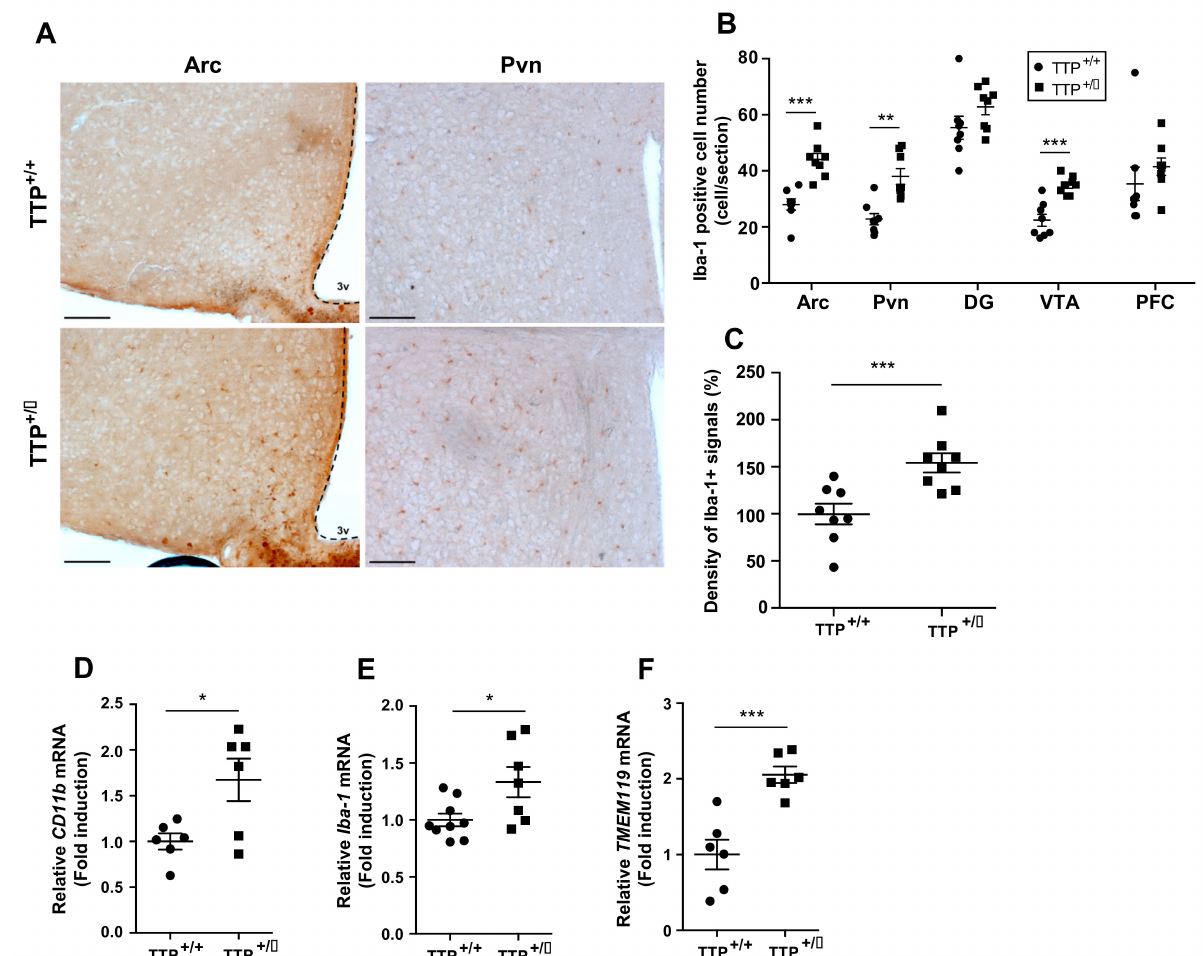
Figure 4. Deficiency of TTP leads to the activation of microglia in the hypothalamus. ( A ) Representative images show immunosignals of Iba-1 protein, a molecular marker for microglial cells, in the hypothalamus as determined by IHC. ( B ) Iba-1 positive cells were significantly elevated in hypothalamic arcuate nucleus (Arc), paraventricular nucleus (Pvn) and ventral tegmental area (VTA), but not significantly altered in the hippocampal dentate gyrus (DG) and prefrontal cortex (PFC) of the TTP-deficient mice compared to that of wild type mice. ( C ) A significant increase in the intensity of Iba-1 immunosignals was observed in the hypothalamic Arc of the TTP-deficient mice compared to that of wild type mice as determined by IHC. qPCR data reveal increased levels of ( D ) CD11b , ( E ) Iba-1 , and ( F ) TMEM119 , molecular markers for microglia activation, in total hypothalamus of the TTP-deficient mice compared to that of wild type mice. Data are presented as the mean ± SEM. n = 8 mice per group for IHC data (Figure 4A–C); n = 6–9 mice per group for qPCR data (Figure 4D–F). * p < 0.05, ** p < 0.01. *** p < 0.001. Scale bar = 100 µ m. SEM; standard error of the